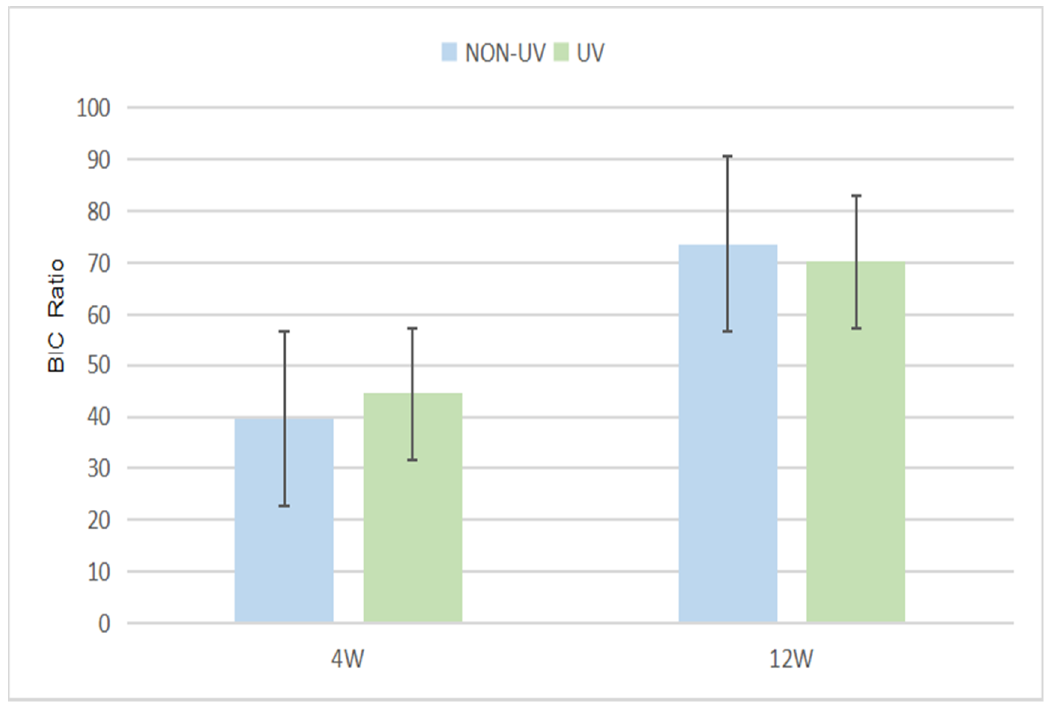
Figure 4. Comparative Results of Bone-to-Implant Contact Ratios at 4 and 12 weeks of implant placement. The average IST values for the UV-irradiated group were as follows: 52.2 ± 6.8% immediately after implantation, 45.6 ± 4.1% at 1 week, 69.8 ± 5.5% at 4 weeks, and 74.5 ± 3.4% at 12 weeks ( p > 0.05). The average IST values for the non-irradiated group were as follows: 48.3 ± 4.6% immediately after implantation, 46.6 ± 4.5% at 1 week, 60.3 ± 11.6% at 4 weeks, and 70.6 ± 3.3% at 12 weeks ( p > 0.05) (Figure 5).